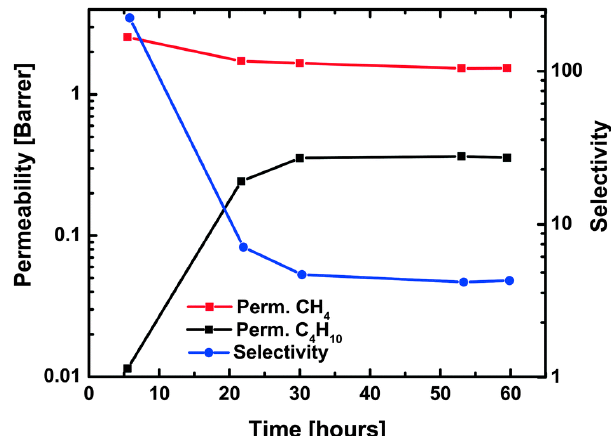
Figure 68. Permeability and selectivity for a 75/25 CH 4 /n-C 4 H 10 mixture over time, measured using the time-lag method on ZIF-8 membrane at 308 K (adapted with permission from ref. [53]).